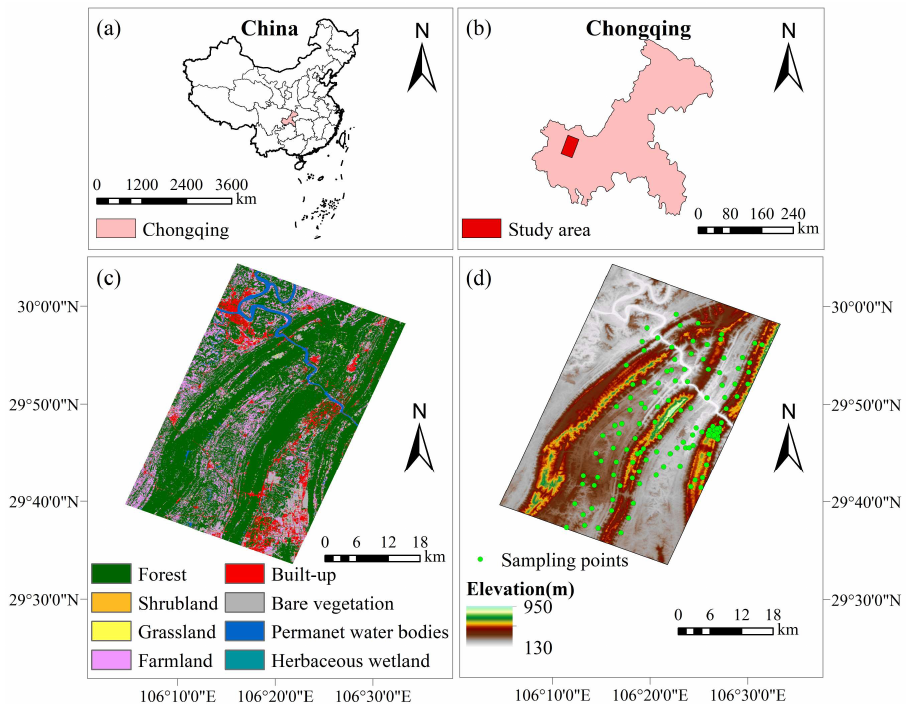
Figure 1. Spatial location of the study area ( a , b ), land use/land cover map ( c ) and spatial distribution of the sampling points ( d ) in the study area.